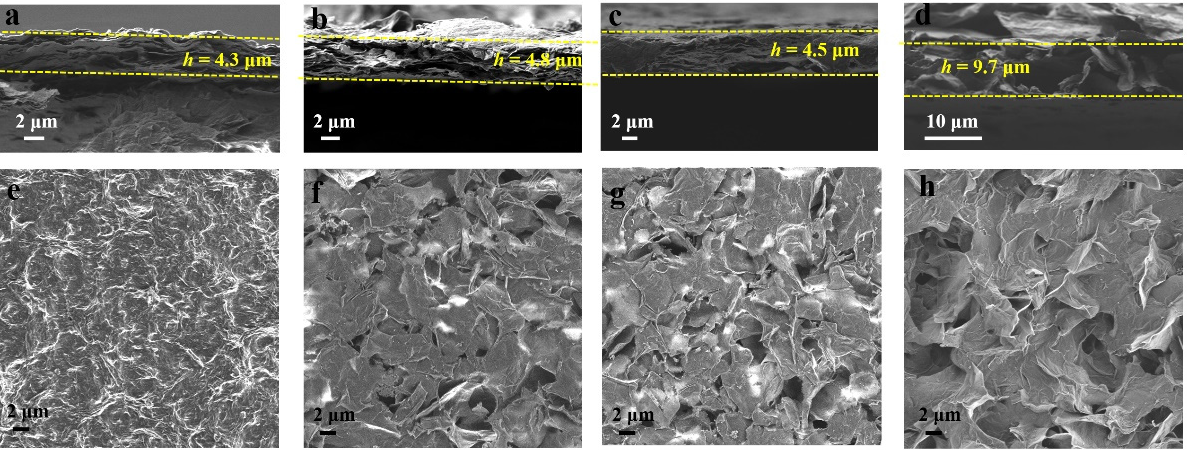
Figure 3. SEM images showing the cross-sectional view of ( a ) RGO-RT-15, ( b ) RGO-RT-50, ( c ) RGO- RT-100, and ( d ) RGO-105-50. SEM images showing the top view of ( e ) RGO-RT-15, ( f ) RGO-RT-50, ( g ) RGO-RT-100, and ( h ) RGO-105-50.